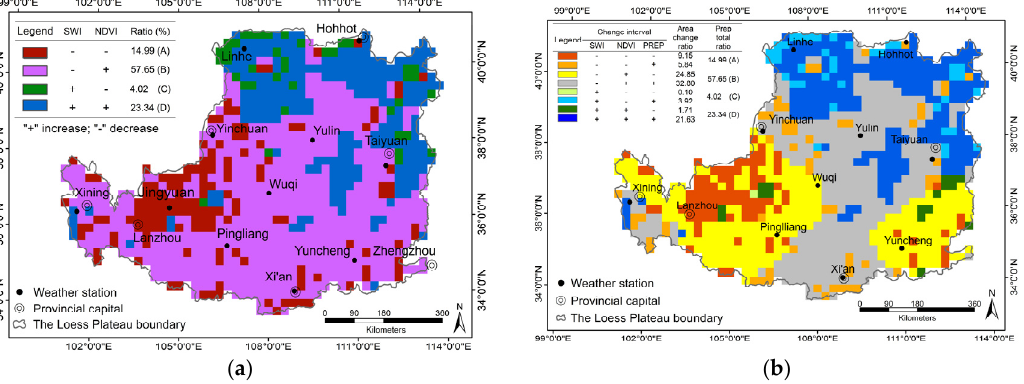
Figure 6. Spatial distribution of area change in the SWI and NDVI ( a ); SWI, NDVI, and precipitation ( b ) on the Loess Plateau.